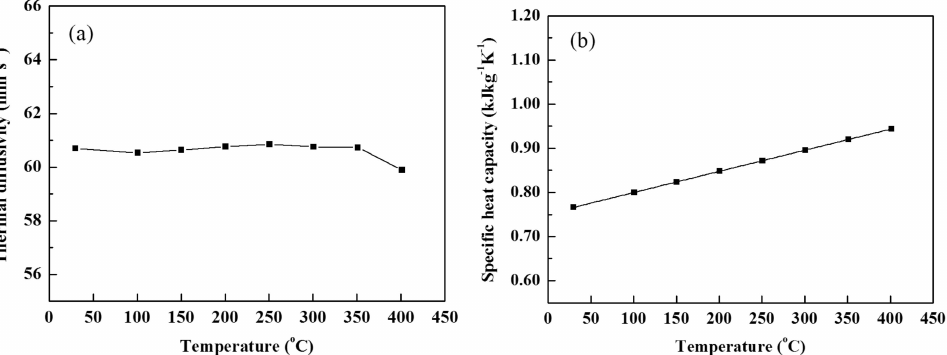
Figure 6. Thermal diffusivity ( a ) and specific heat capacity ( b ) of Mg–25%Cu–15%Zn alloy vs.